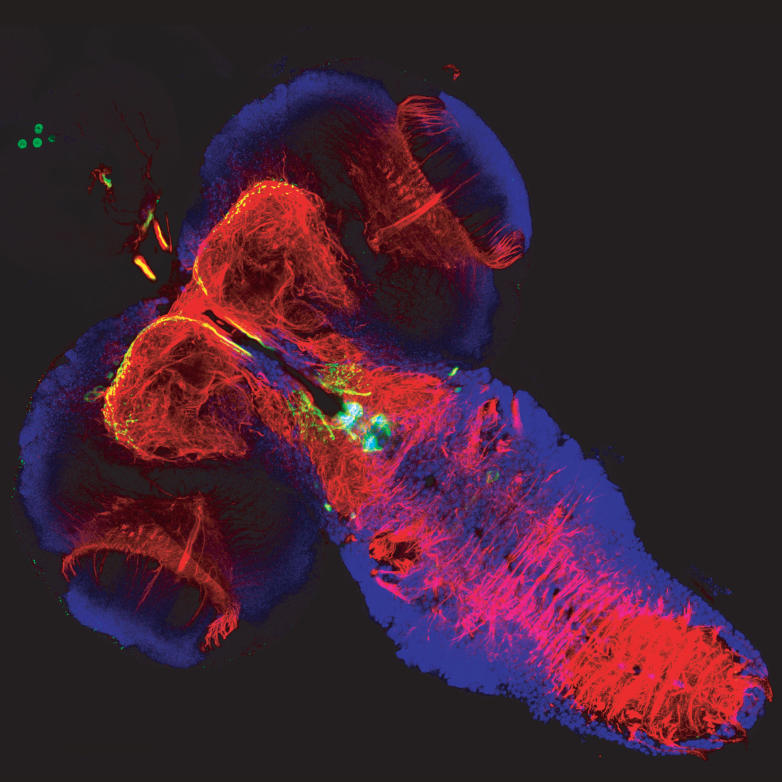
Microarray, neuroanatomical, and biochemical analyses identified taste-sensitive neurons that help regulate feeding behavior in frutifly larvae